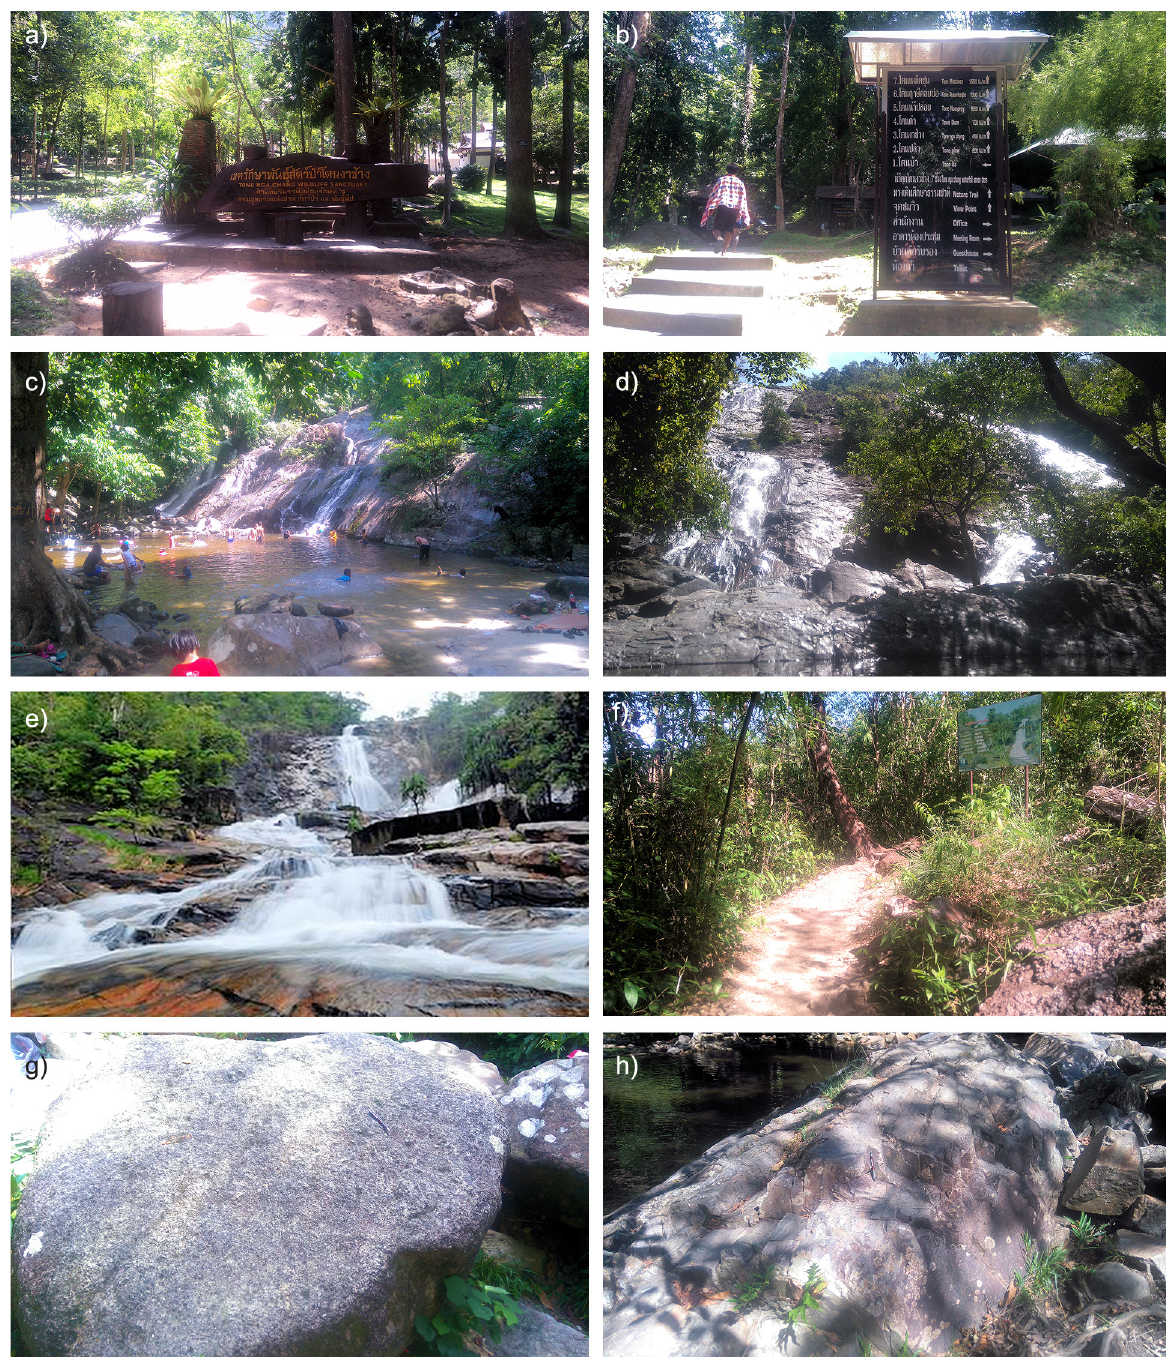
Fig. 6. Tone Nga Chang